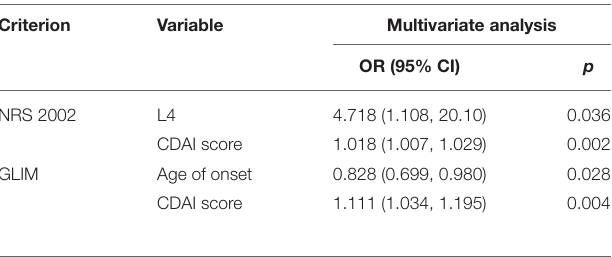
TABLE 3 | Multivariate analysis of factors related to high malnutrition risk by NRS 2002 and malnutrition by GLIM in patients with CD.